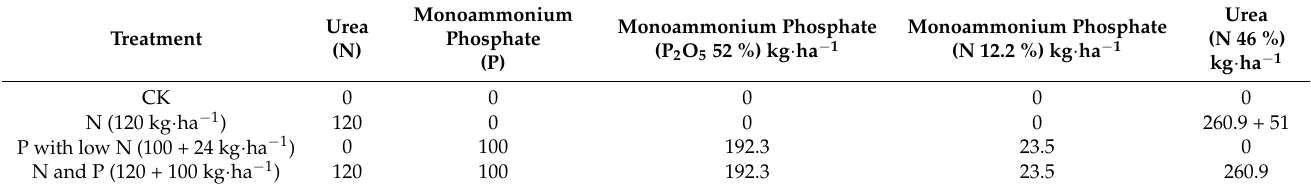
Table 2. Fertilization application amount in each